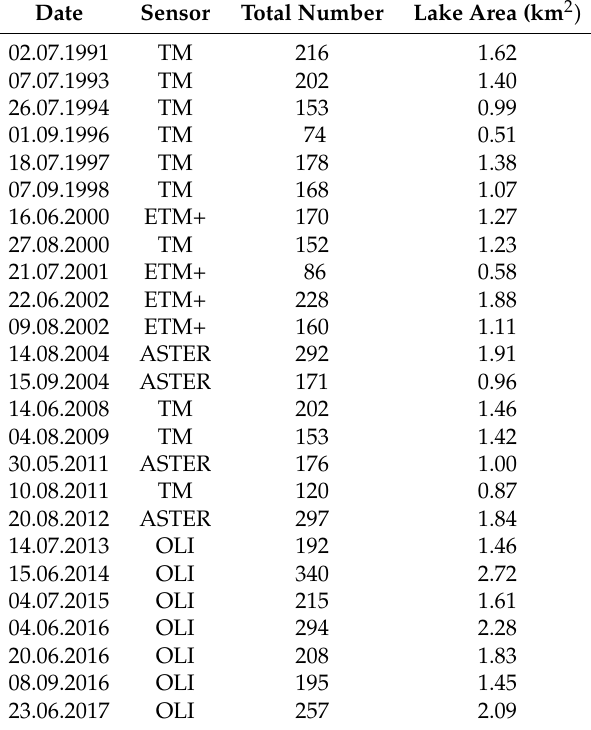
Table 4. Total number and lake area (km 2 ) of the supraglacial lakes for the years